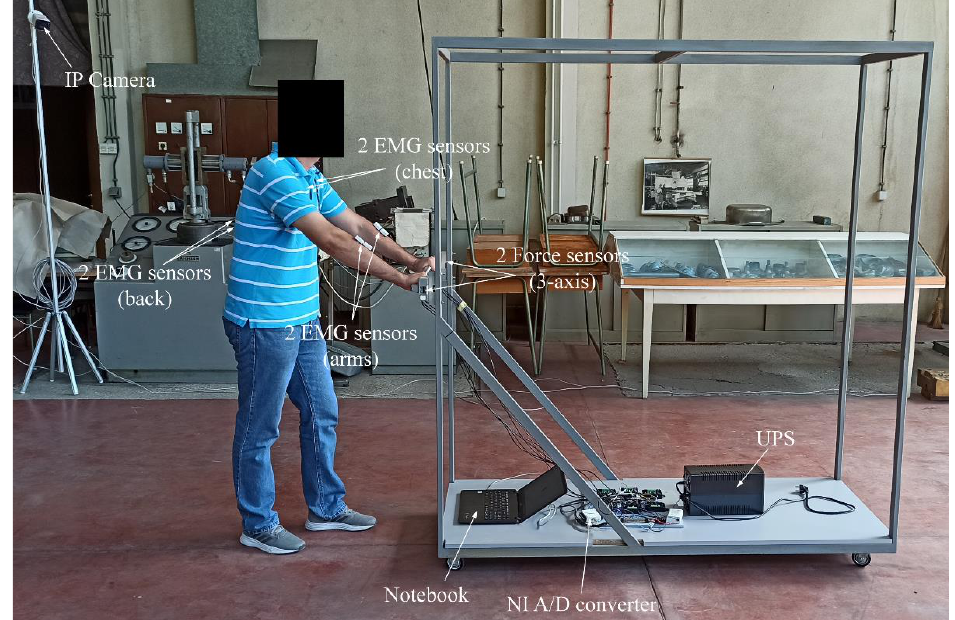
Figure 2. Trolley and equipment used in the experiment.